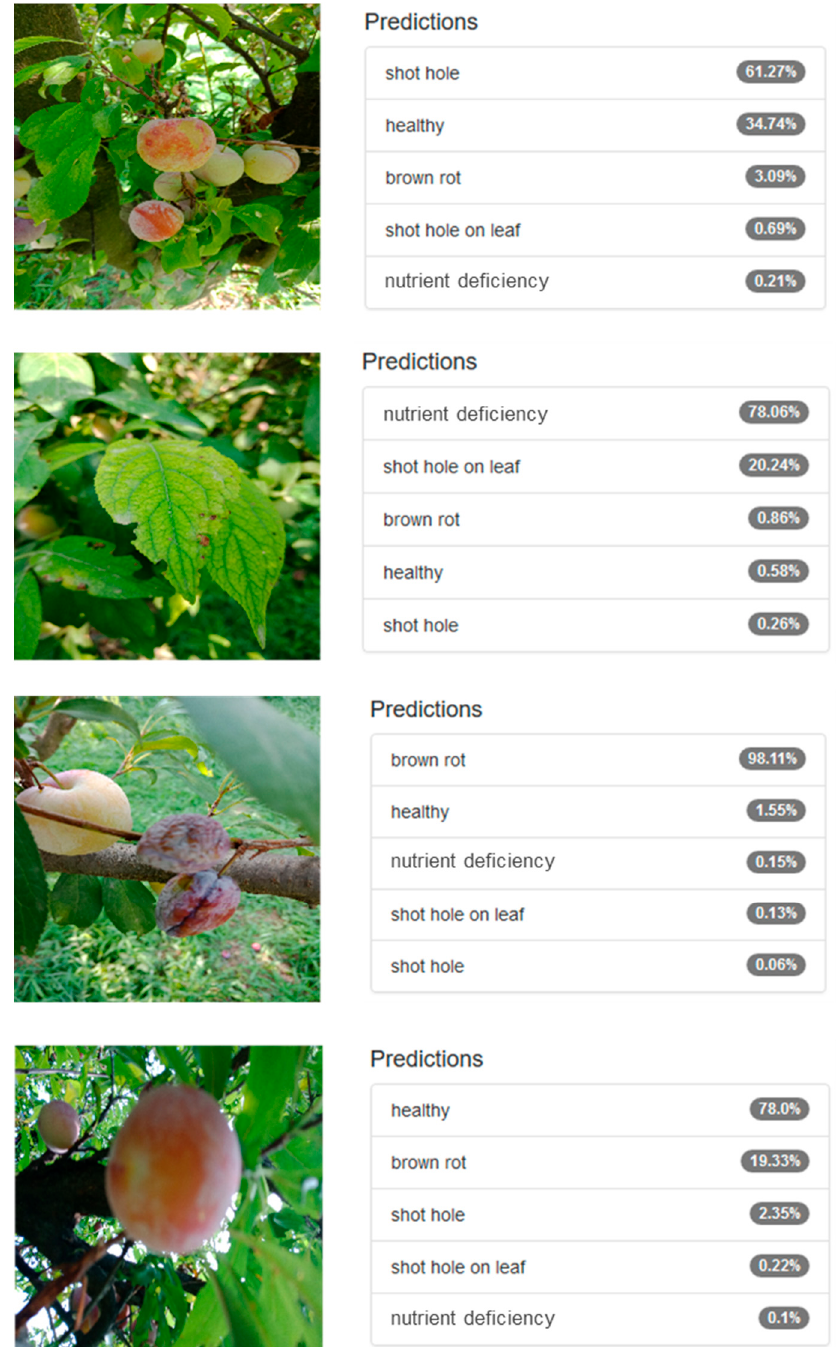
Figure 11. Prediction performance of Inception-v3.